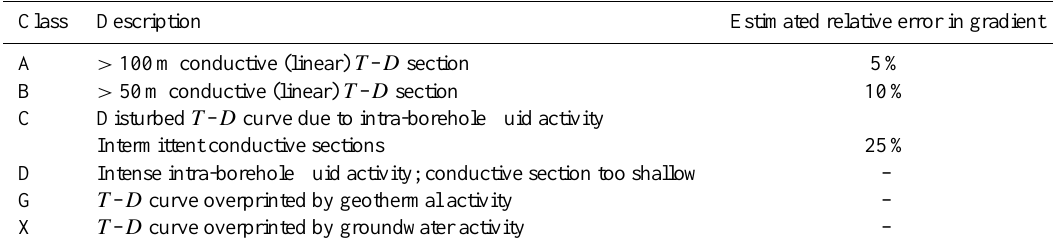
Table 1. Definitions of the data quality classes used in this